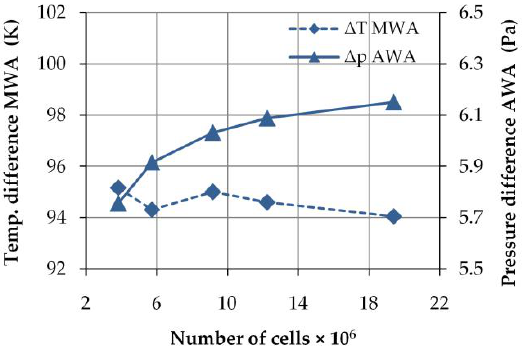
Figure 3. Mesh independence test for a nine-layer reactor with 3-mm spheres (the chosen mesh Figure 3. Meshindependence test for a nine-layer reactor with 3-mm spheres (the chosen mesh contains 12.2  10 6 cells with a size of 0.5/0.17 mm). MWA: mass-weighted average; AWA: contains 12.2 × 10 6 cells with a size of 0.5/0.17 mm). MWA: mass-weighted average; AWA: area- area-weighted average. weighted average.